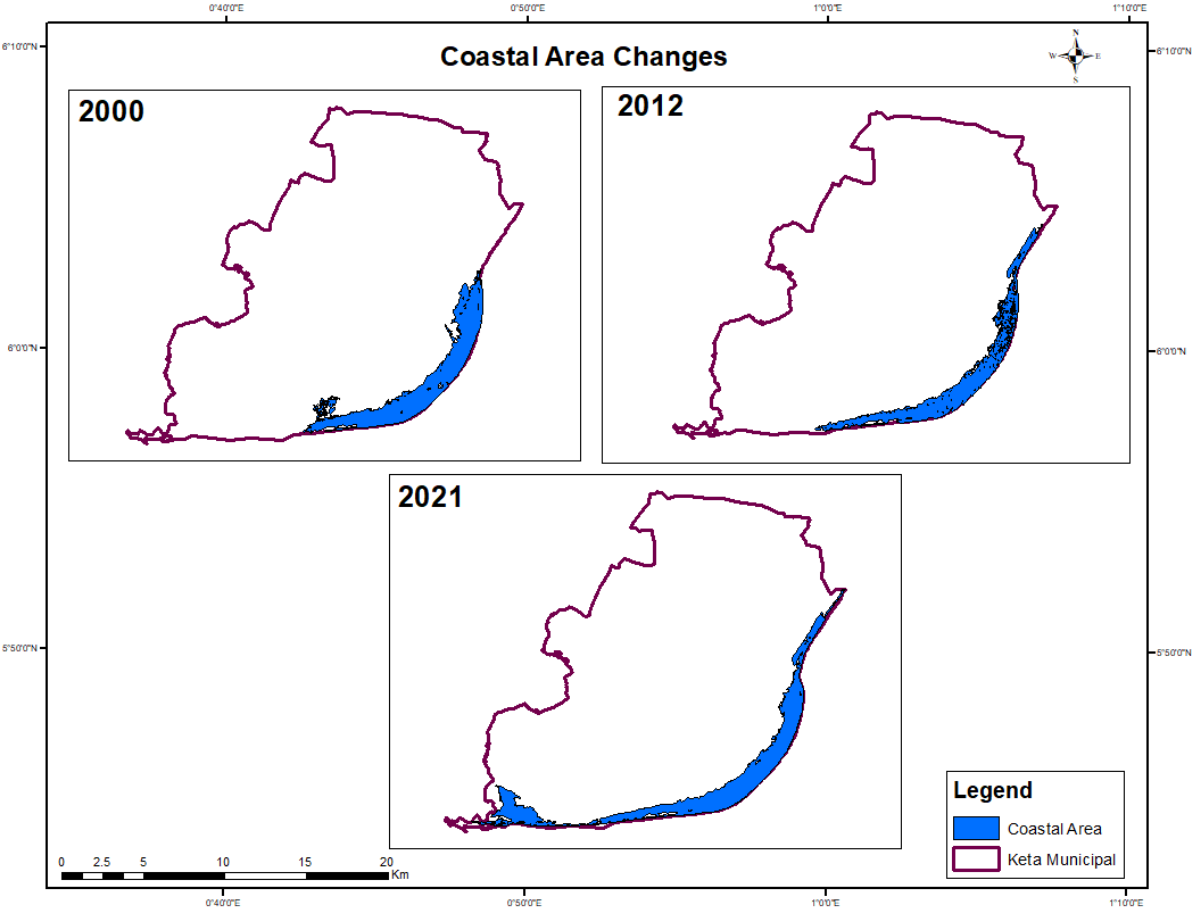
Figure 5. Digitized Coastal Areas in hectares (ha) from 2000 to